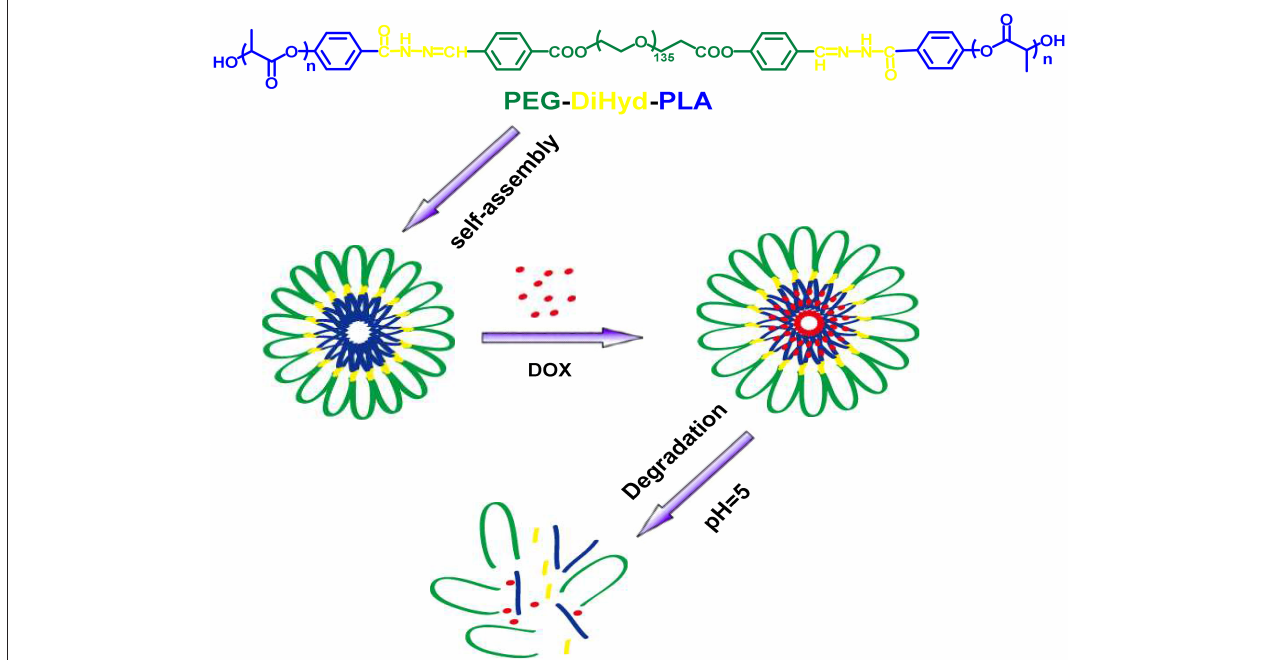
FIGURE 1 | Schematic illustration of the formation of ABA triblock polymer micelle and its degradation in acidic condition.